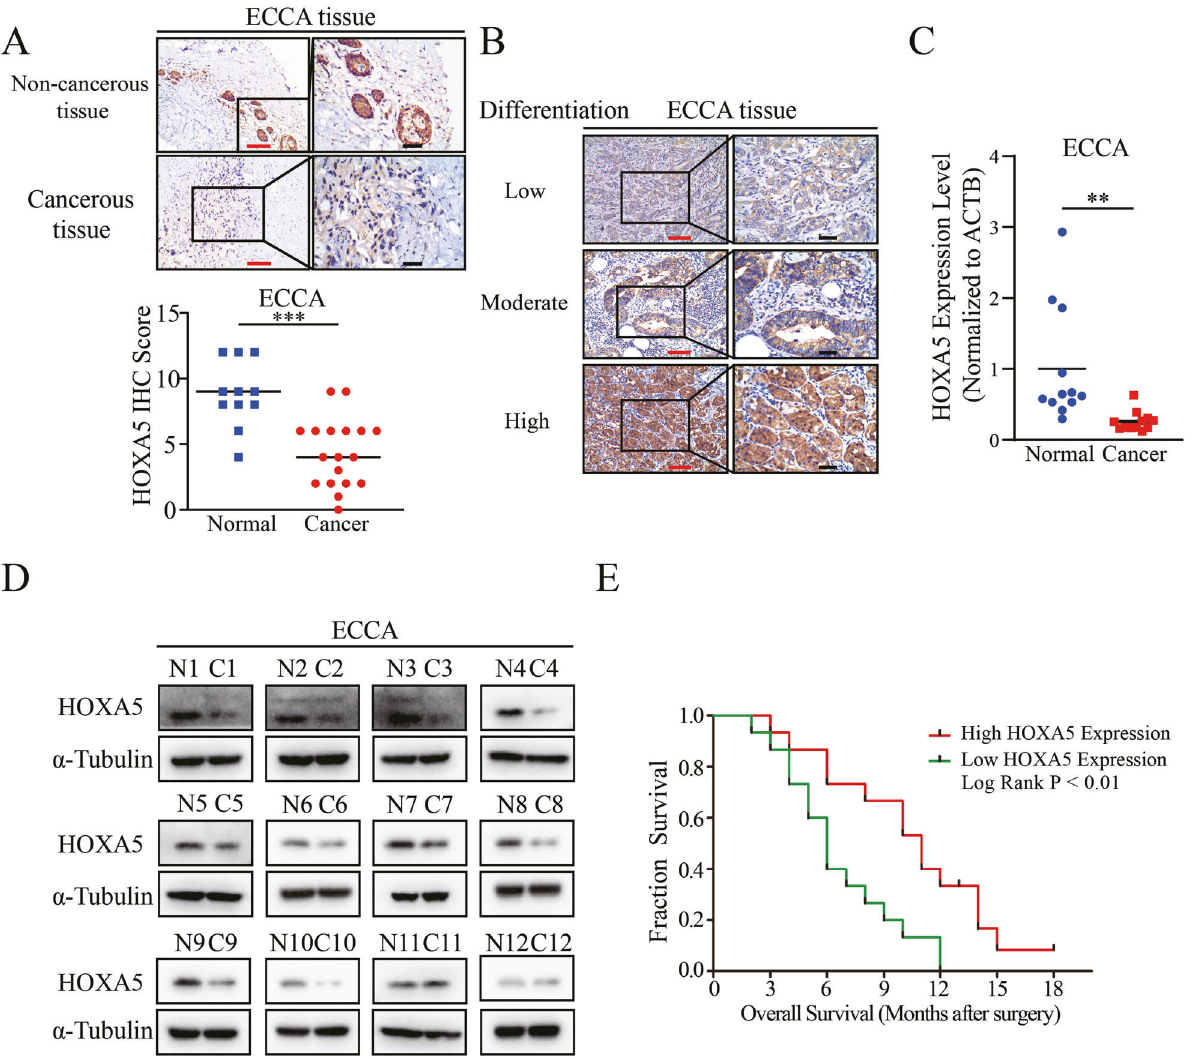
Fig. 2 HOXA5 expression in ECCA tissues. A Immunohistochemistry analysis of HOXA5 expression in ECCA and non-tumor tissues. B Immunohistochemistry analysis of HOXA5 expression in different differentiation levels of ECCA from patients. C , D RT-qPCR and Western blot analyses of HOXA5 expression in ECCA and paired non-tumor tissues. N Non-tumor samples, C ECCA samples. E Lower levels of HOXA5 expression were associated with a worse OS of ECCA in this population. *** P < 0.001. ** P < 0.01. Red bar, 100 μ m. Black bar, 40 μ